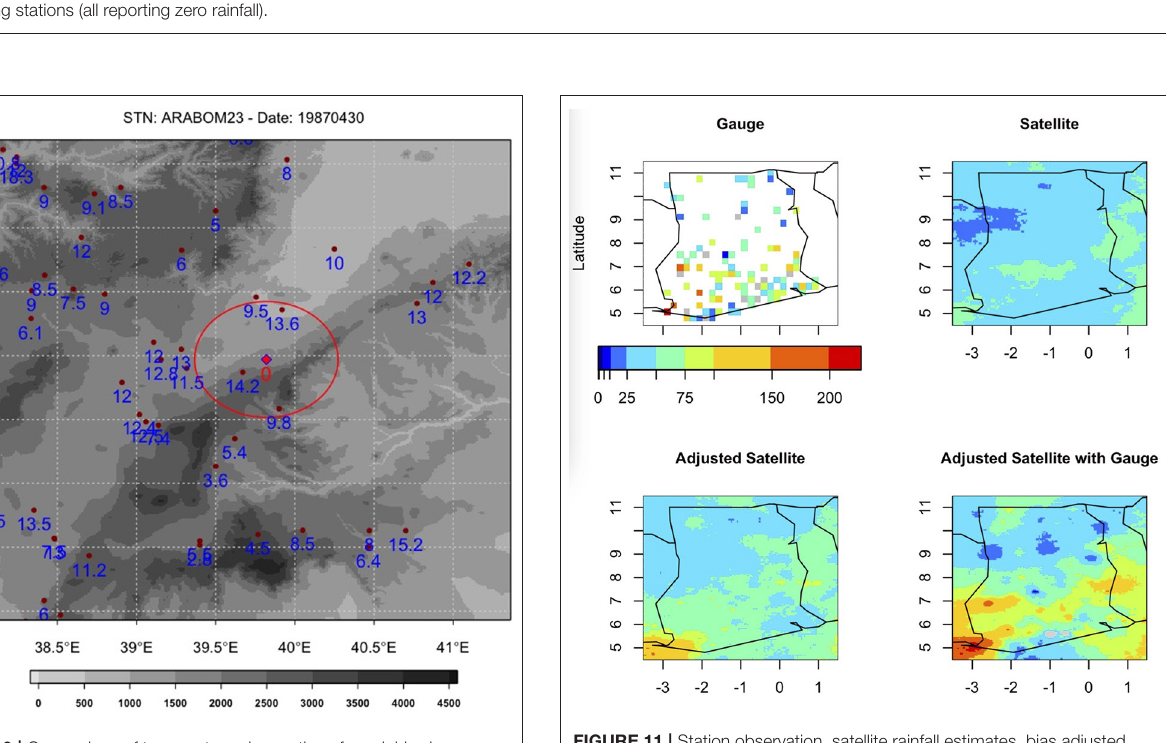
FIGURE 10 | Comparison of temperature observations for neighboring stations with elevation as a